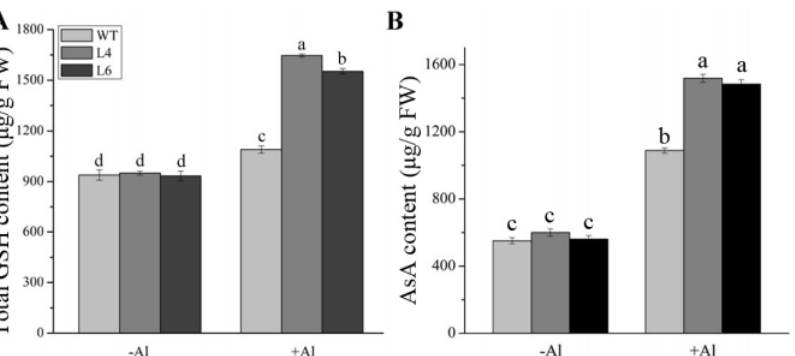
Figure 8. Overexpression of ZmALDH increases the accumulation of total GSH and AsA in roots. The total contents of ( A ) GSH and ( B ) AsA in WT and transgenic Arabidopsis (L4 and L6) were detected after exposure to 60 µ M AlCl 3 for 12 h. Values represent mean ± SD ( n = 20). Different letters indicate significant differences ( p < 0.01) (Tukey’s test).